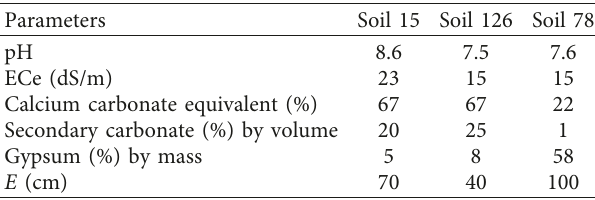
Figure 7: Classification of soils obtained by the MFIS. Table 4: Characteristics of Solonchaks 15, 126, and